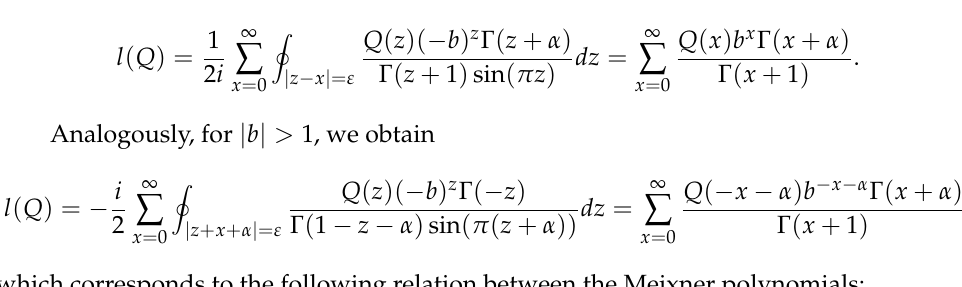
∞ { z : | z − x | = ε } , thus x = 0